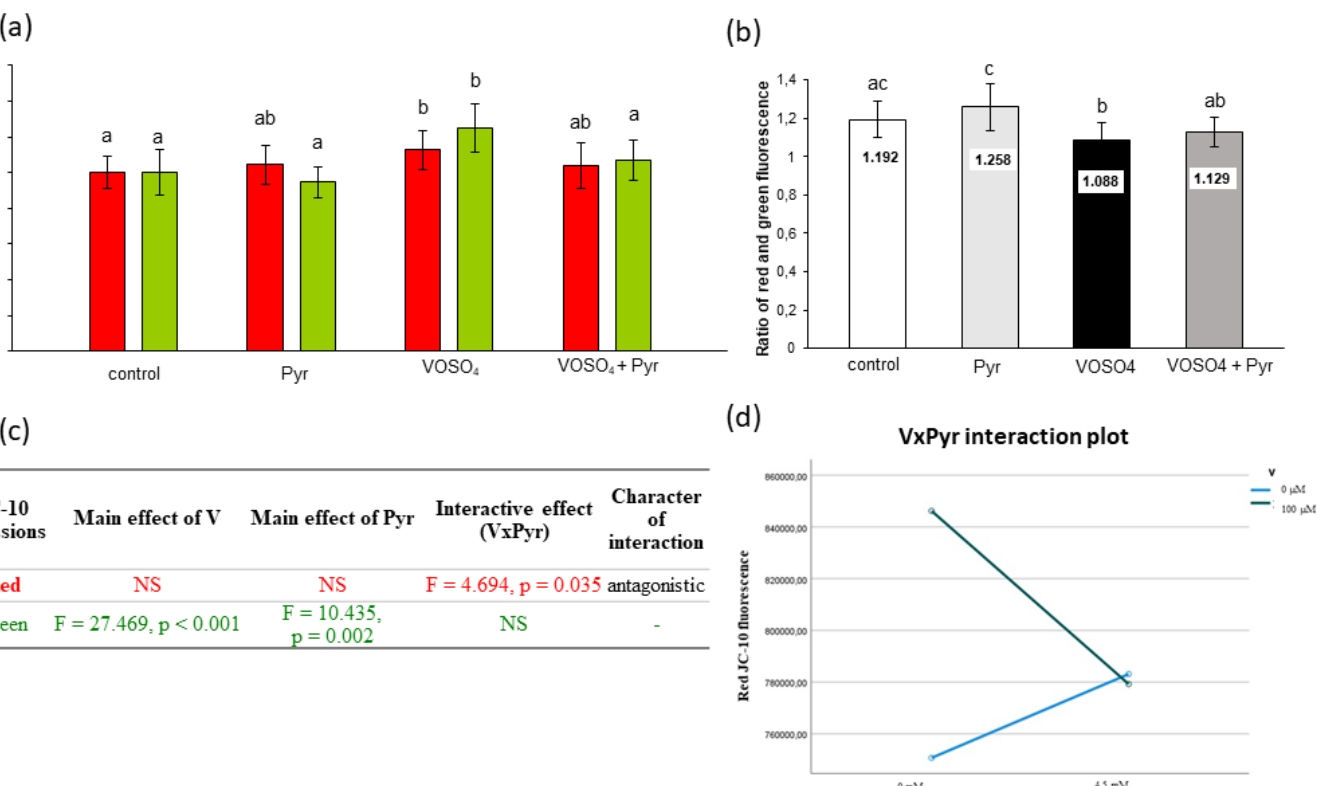
Figure 5. Effects of vanadium and/or pyruvate on MMP in CHO-K1 cells detected with the JC-10 staining method. The cells were incubated in DMEM/F12 medium without (control) or with 100 μM VOSO 4 in the presence or absence of sodium pyruvate (Pyr) (4.5 mM) for 24 h. ( a ) Red and green JC-10 fluorescence emissions expressed in percentage, and ( b ) red/green fluorescence intensity ratio. Data represent the mean ± SD derived from 3 independent experiments each performed at least in triplicates. Means within the same color followed by a common letter are not significantly different. Data were analysed by one-way ANOVA followed by Tukey’s post hoc test; ( c ) Results of the two-way ANOVA analysis of red and green JC-10 fluorescence emissions after 24-h exposure to V (as VOSO 4 ) and Pyr (pyruvate); NS: no significant effect; ( d ) interaction graph illustrating antagonistic interaction between V and Pyr for red JC-10 fluorescence emissions after 24-h incubation.